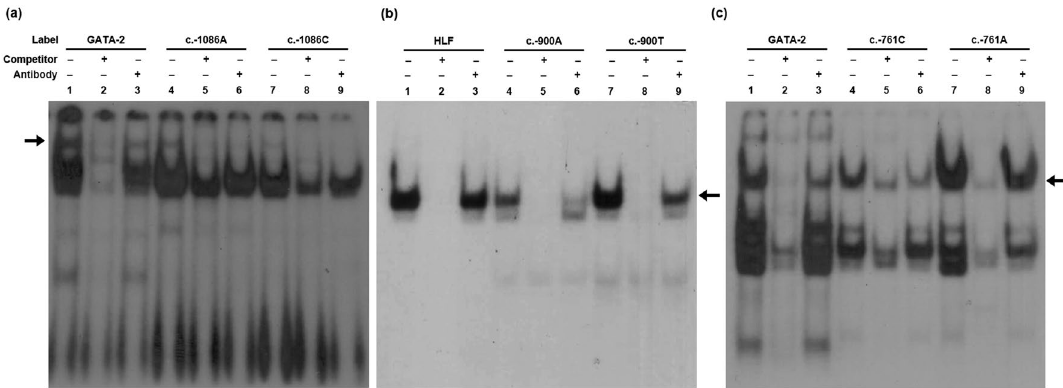
Figure 5. Gel shift assays. (a) 32 P-labeled oligonucleotides (lanes 1–3, GATA-2 consensus; lanes 4–6, wild-type c.-1086A; lanes 7–9, c.-1086C variant) were incubated with nuclear protein extracts. Competition and supershift assays were performed using 100-fold molar excess of unlabeled GATA-2 consensus oligonucleotides (lanes 2, 5, and 8) and GATA-2 antibody (lanes 3, 6, and 9), respectively. (b) 32 P-labeled oligonucleotides (lanes 1–3, HLF consensus; lanes 4–6, wild-type c.-900A; lanes 7–9, c.-900T variant) were incubated with nuclear protein extracts. Competition and supershift assays were performed using 100-fold molar excess of unlabeled HLF consensus oligonucleotides (lanes 2, 5, and 8) and HLF antibody (lanes 3, 6, and 9), respectively. (c) 32 P-labeled oligonucleotides (lanes 1–3, GATA-2 consensus; lanes 4–6, wild-type c.-761C; lanes 7–9, c.-761A variant) were incubated with nuclear protein extracts. Competition and supershift assays were performed using 100-fold molar excess of unlabeled GATA-2 consensus oligonucleotides (lanes 2, 5, and 8) and GATA-2 antibody (lanes 3, 6, and 9), respectively. Each arrow indicates the band of the DNA–protein complex. Full film data were presented in Supplementary Fig. 3.